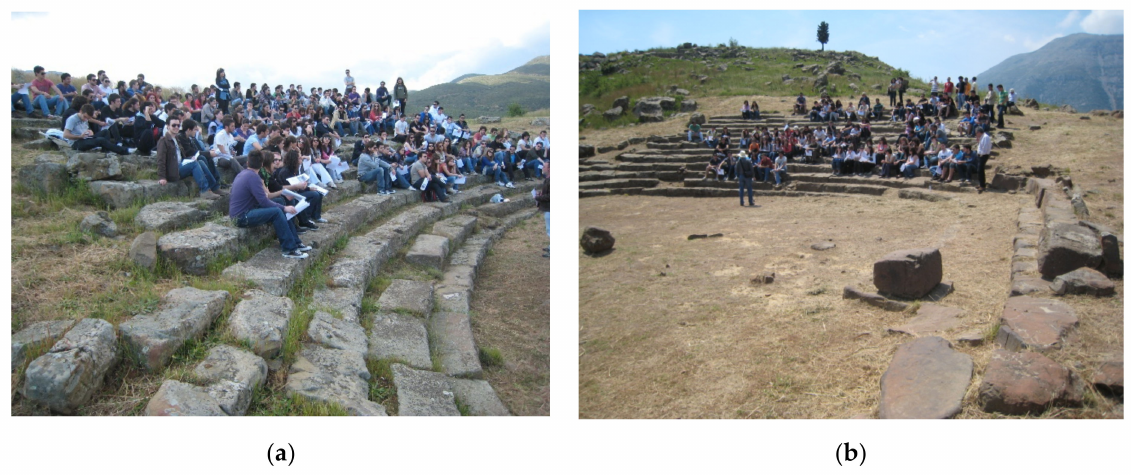
Figure 3. The atypical theatre of Makyneia. ( a ) The lower rows of seat of the circular part of the koilon (sitting place) is seen from the south. Slightly and badly displaced slabs forming the sitting place are seen. (Photo taken on May 2010). ( b ) The theatre from the east, showing the orchestra (stage) and to the right, the unusual, rectilinear part of the koilon . In the background, the Makyneia fortifications. (Photo taken on May